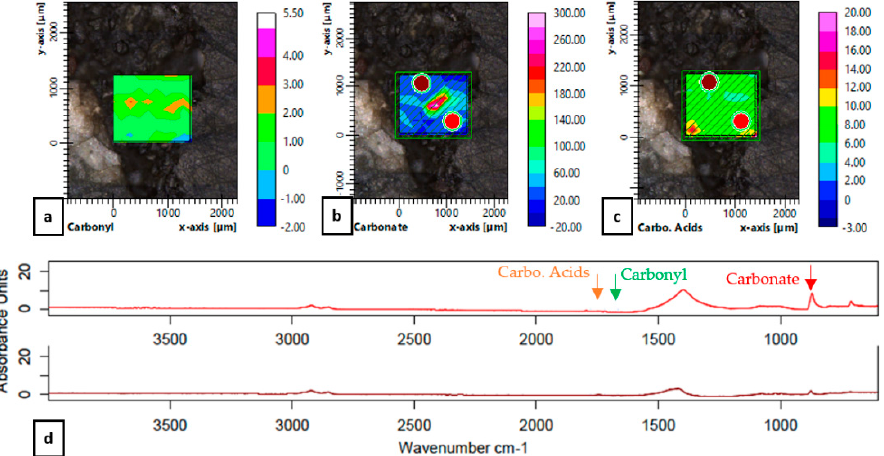
Figure 12. Chemical imaging of the GRAR sample (Area 5): carbonyl group ( a ); carbonate group ( b ); carboxylic acids ( c ); spectral visualization of the selected points marked by colored dots in Figure 12b,c ( d ).